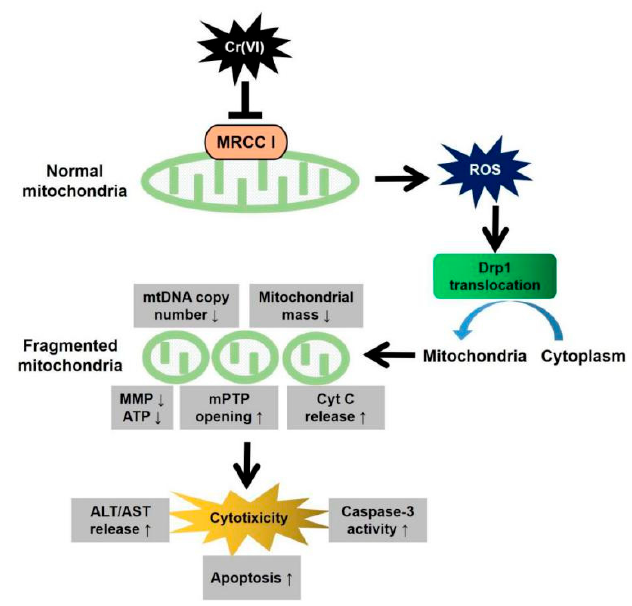
Figure 8. Summary chart of the research content of this paper. Increased mitochondrial fragmentation mediated by Drp1 contributes to Cr(VI)-induced MRCC I-dependent cytotoxicity.